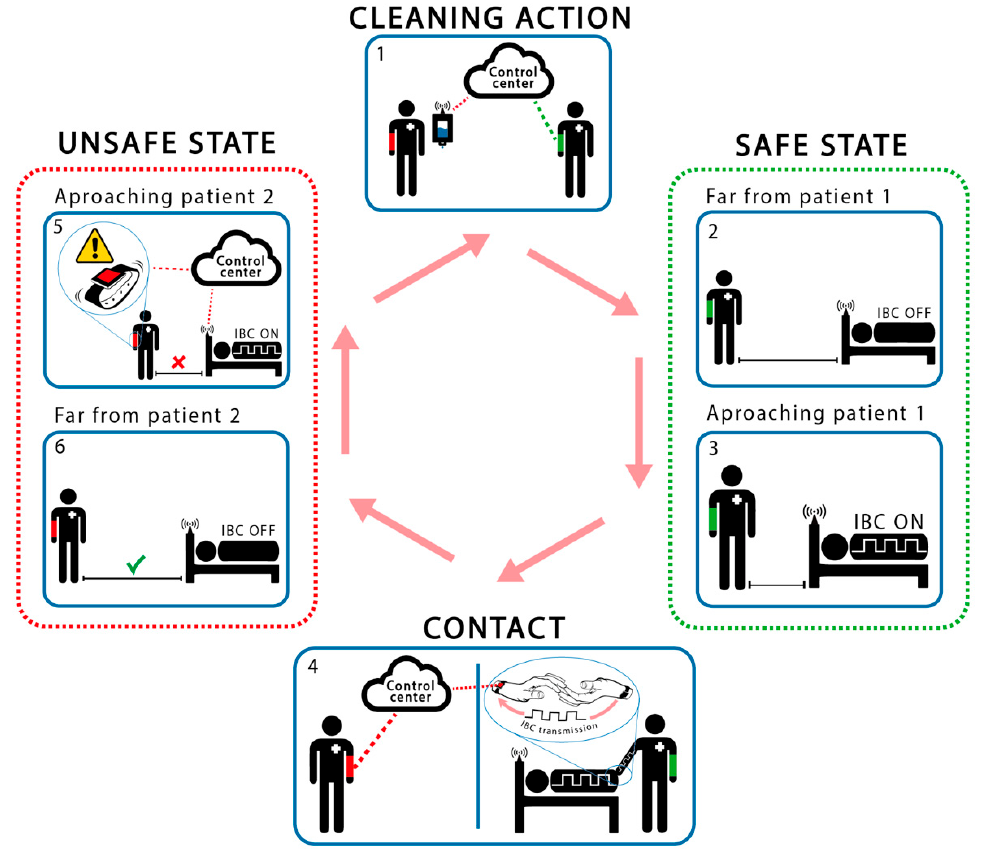
Figure 3. Operation of the proposed AHHMS.